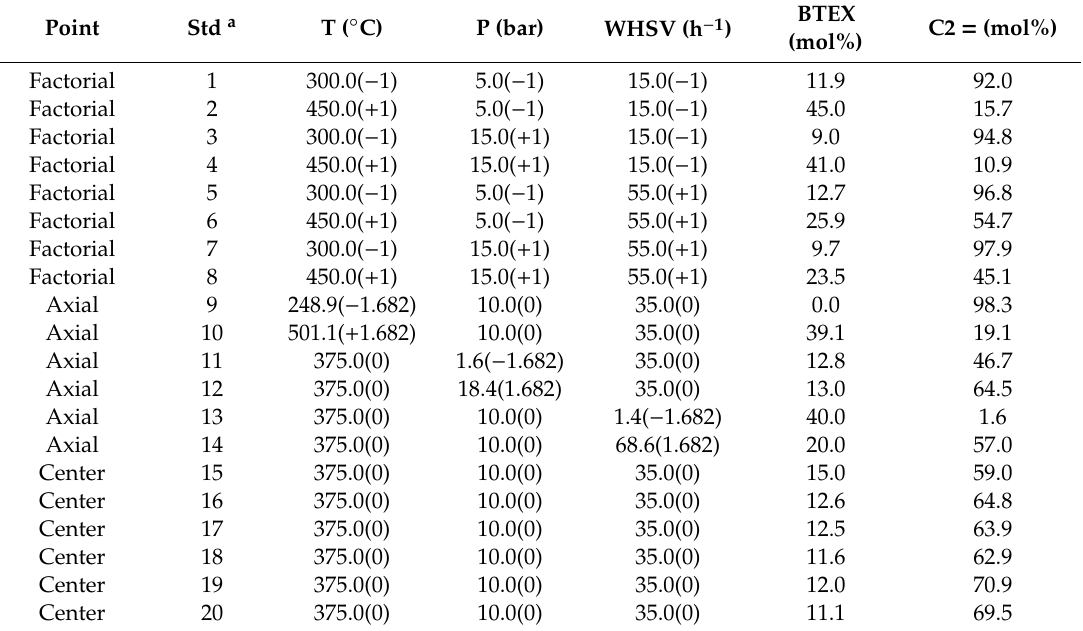
Table 5. Full factorial central composite design matrix and experimental data of the ethanol conversion into